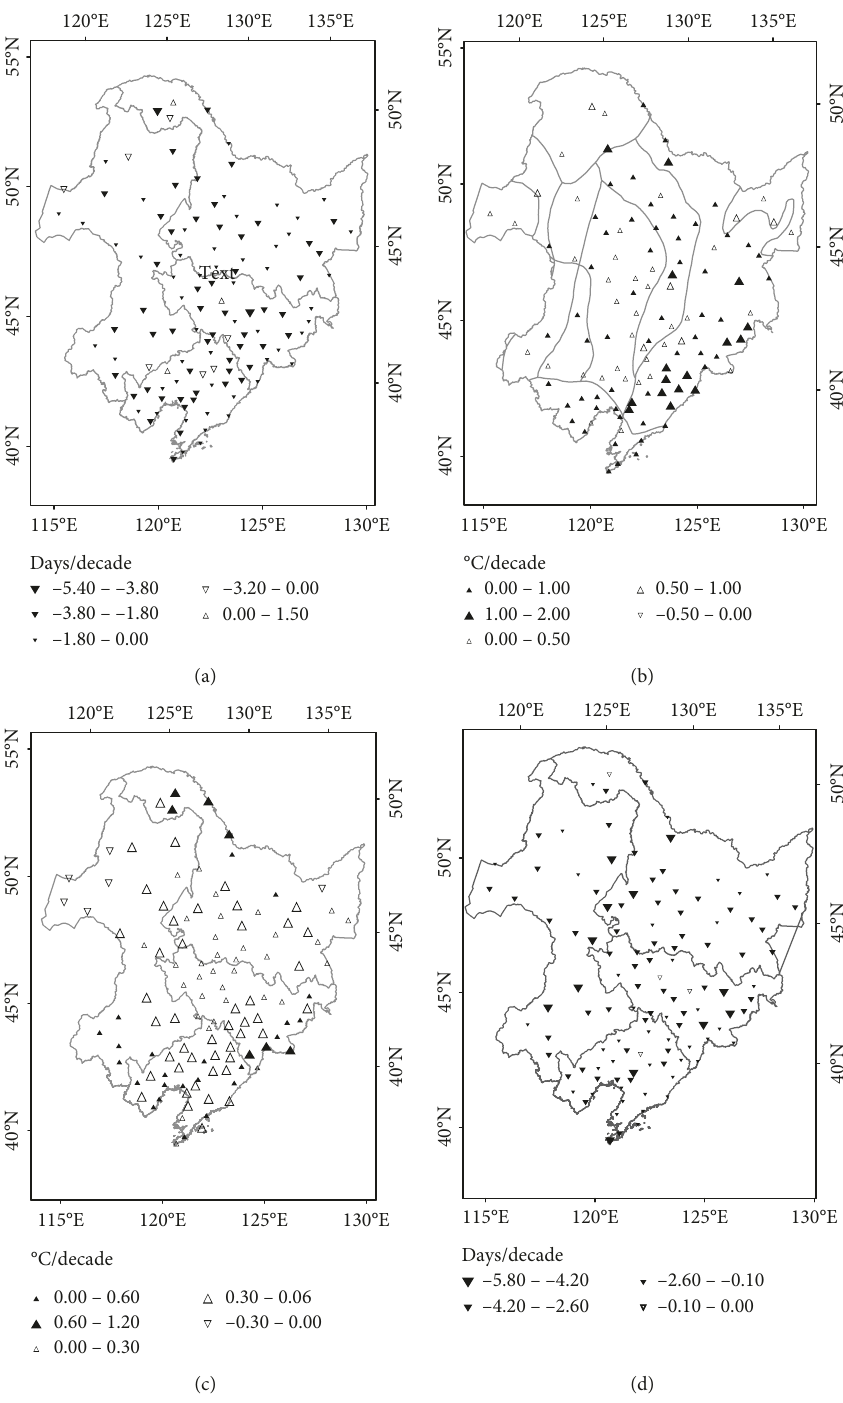
Figure 2: Spatial distributions of trends per decade for the period of 1957–2015 in Northeast China for extremely cold temperature indices (TN10p (a), TNn (b), TXn (c), and FD (d)). The up and down triangles represent positive and negative trend, respectively. Filled triangles indicate that the trend is significant at 95% confidence level, and vice versa. The size of the triangle is proportional to the magnitude of the